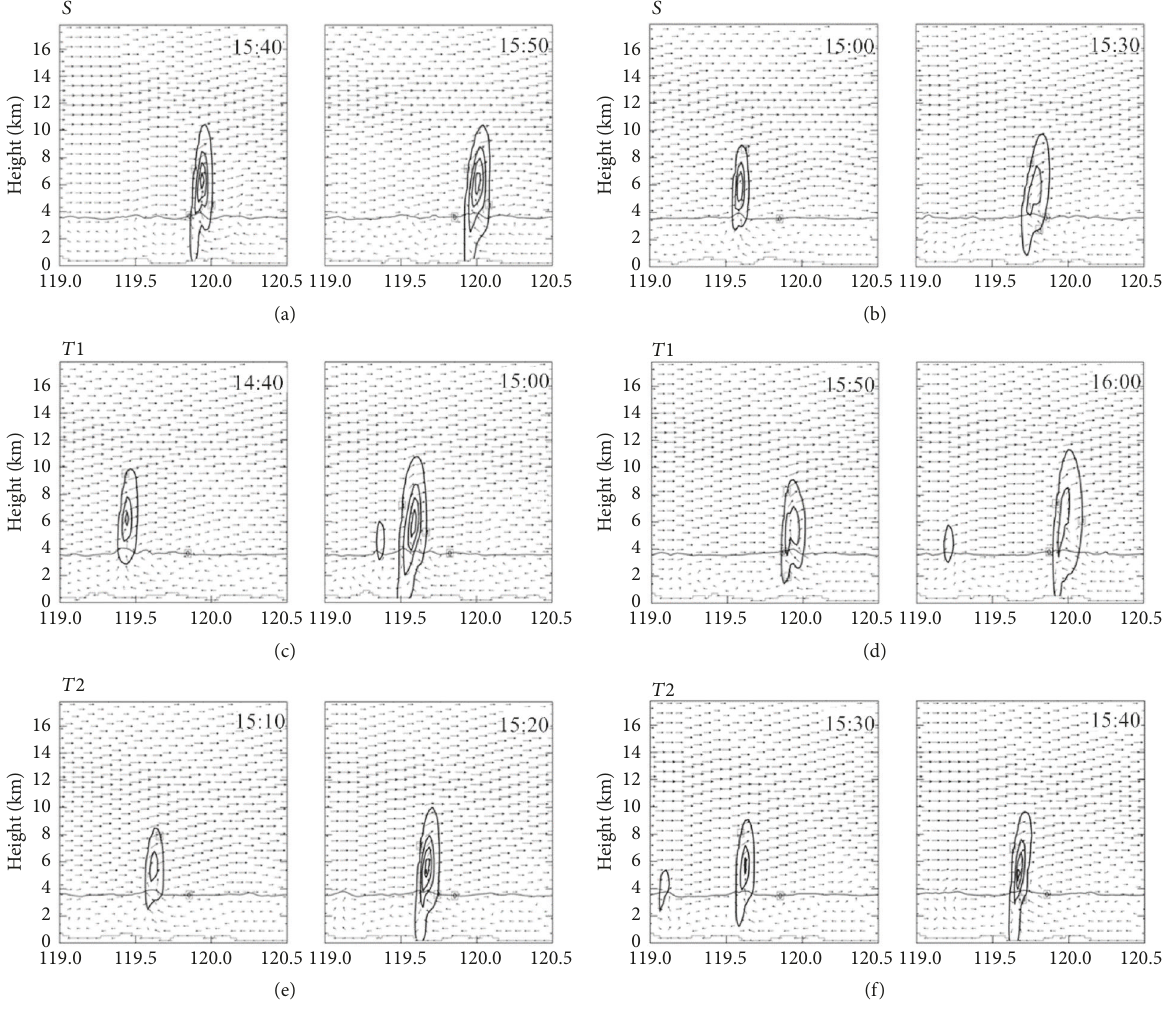
Figure 11: Cross section of the simulated hail water mixing ratio (solid line, minimum 0.1g ⋅ kg −1 , interval 1g ⋅ kg −1 ), UW wind vector, and 0 ∘ C line (thin solid line) in latitudinal direction based on the different schemes: (a) original scheme; (b) Philips; (c) Cooper; (d) Fletcher; (e) Chi NJ; and (f) Chi Mt.